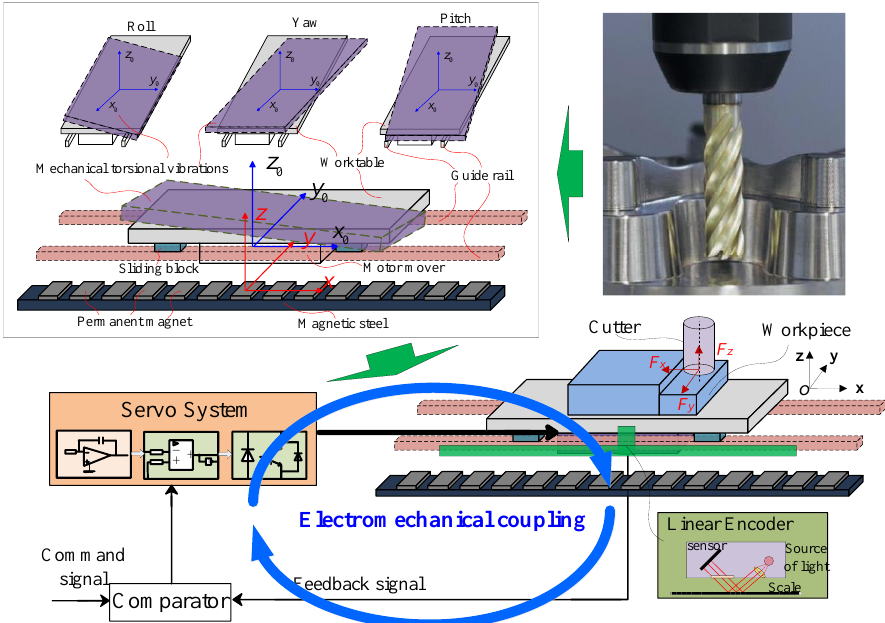
Figure 2. The electromechanical coupling considering the machining process in the direct drive feed system.